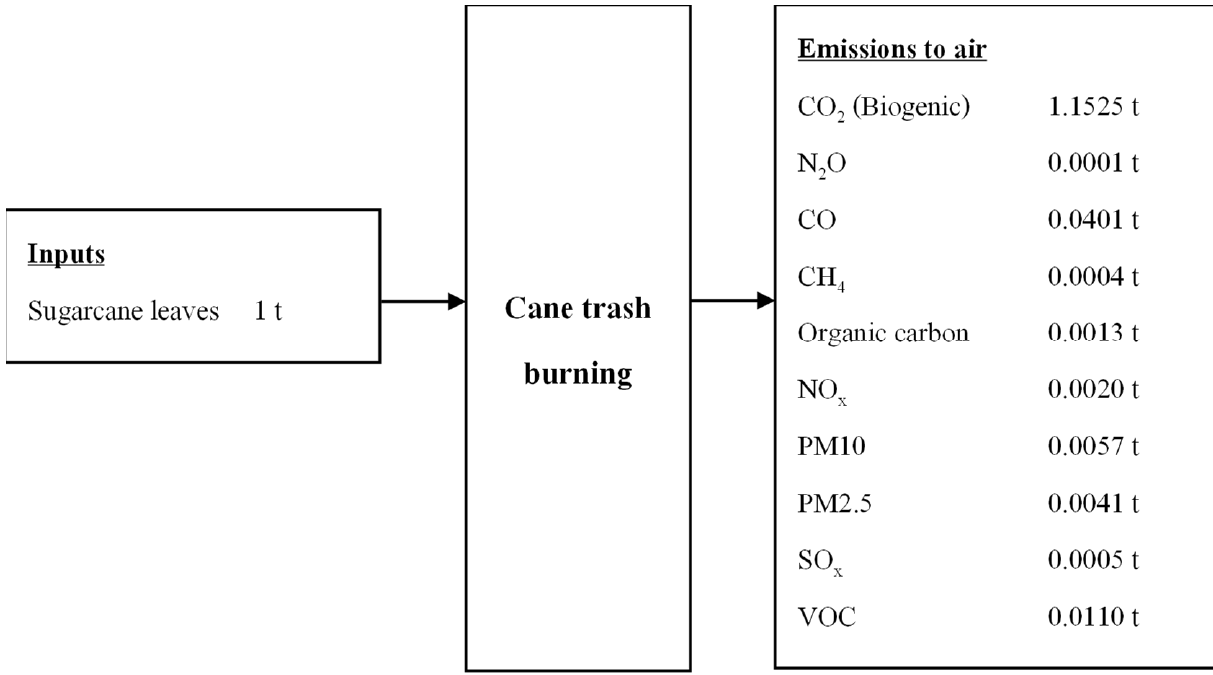
Figure A1. Inputs-Outputs for the base case sugarcane trash burning (BSL). Remark: Emissions to air are calculated based on [43–46].